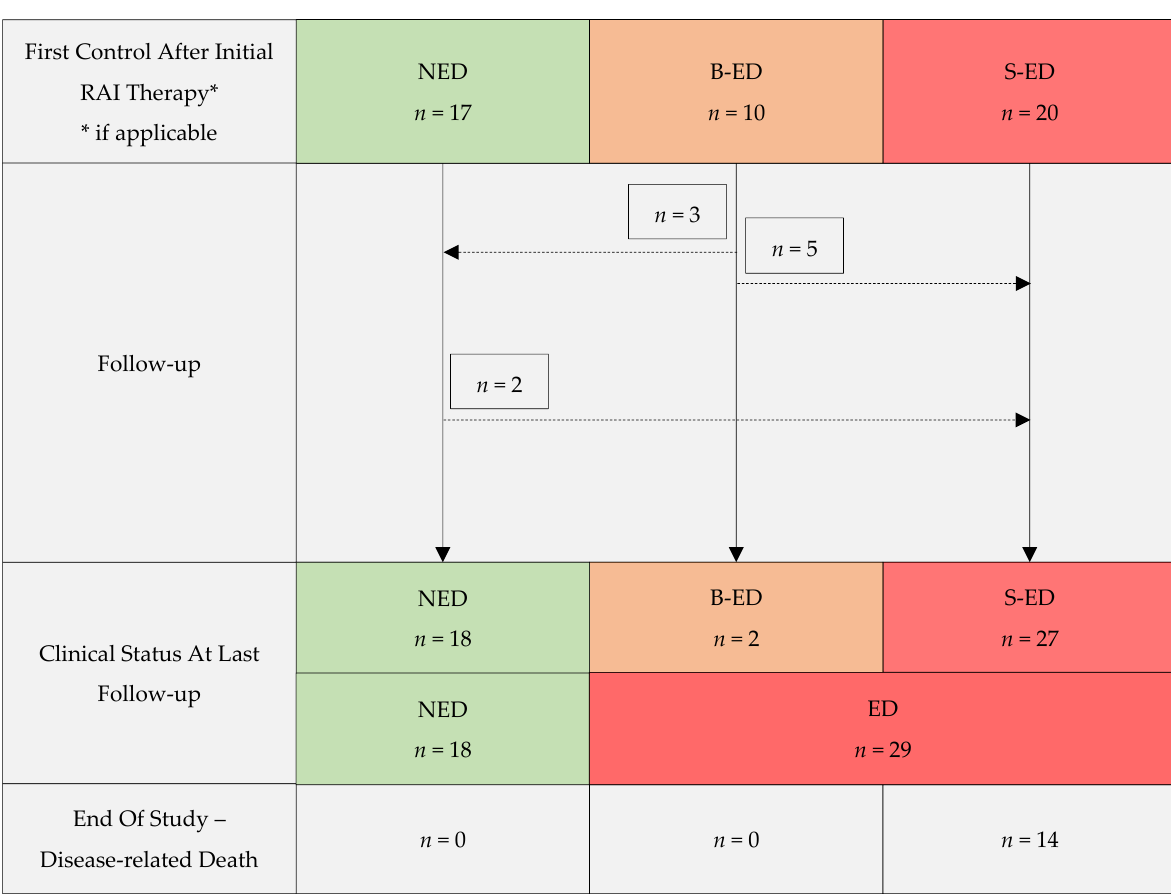
Figure 1. Risk stratification of patients with poorly differentiated thyroid carcinoma; ED, evidence of disease; N, no; B, biochemical; S,